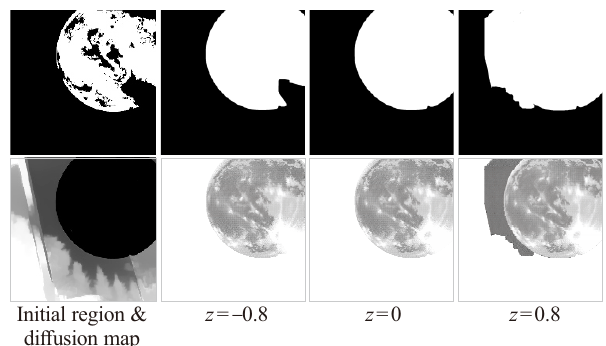
Fig. 8 User control of the extracted region via a single parameter z